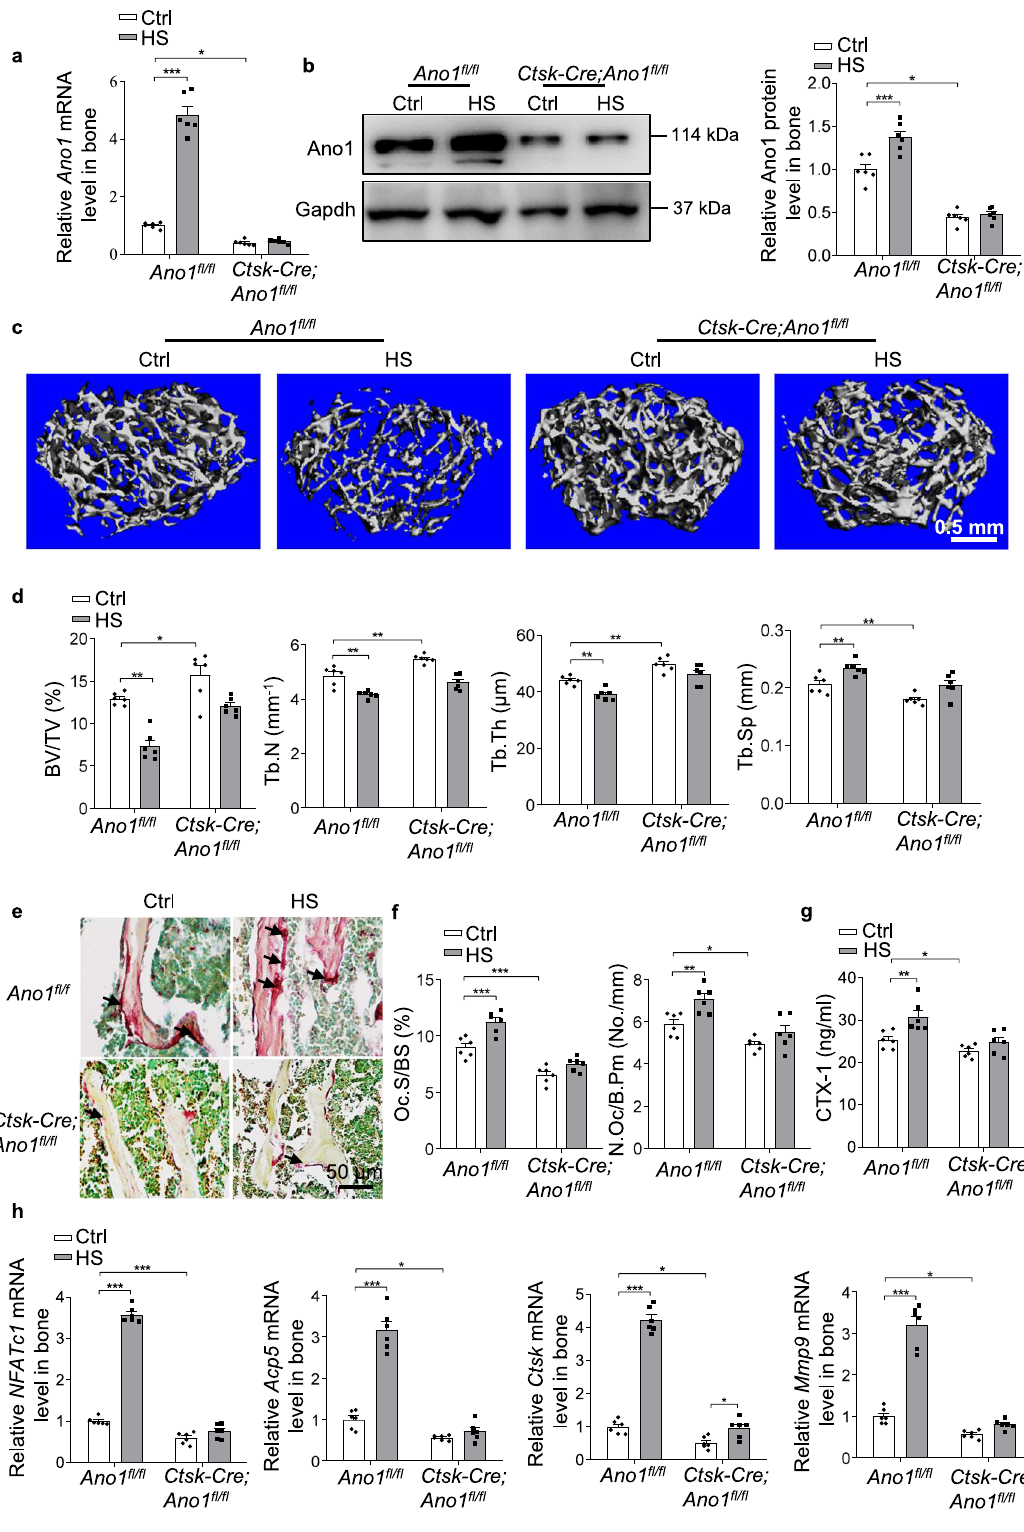
Ano1 in mechanosensation. Here, we found that the response of osteoclast to mechanical stimulation is Ano1-dependent. Ano1 levels and activity underline the effect of mechanical stimulation on osteoclast. Moreover, the expression of Ano1 is modulated by different mechanical stimulation. Mechanical loading decreases Ano1 levels, while mechanical unloading increases Ano1